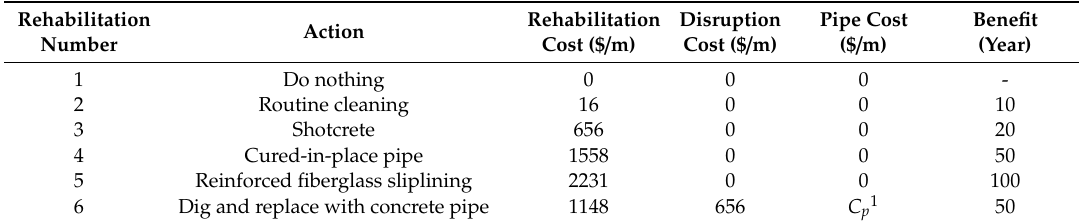
Figure 2. Flowchart of different optimization algorithms.